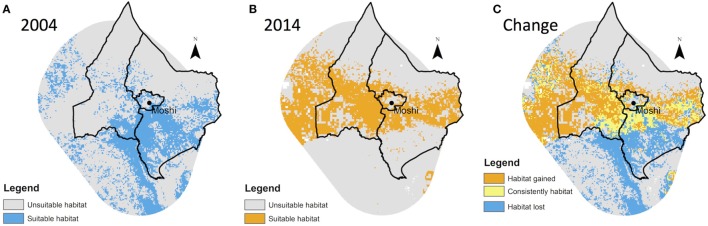
Predicted distribution of Anopheles arabiensis in (A) 2004, (B) 2014, and (C) change showing areas of overlap, loss, and gain.